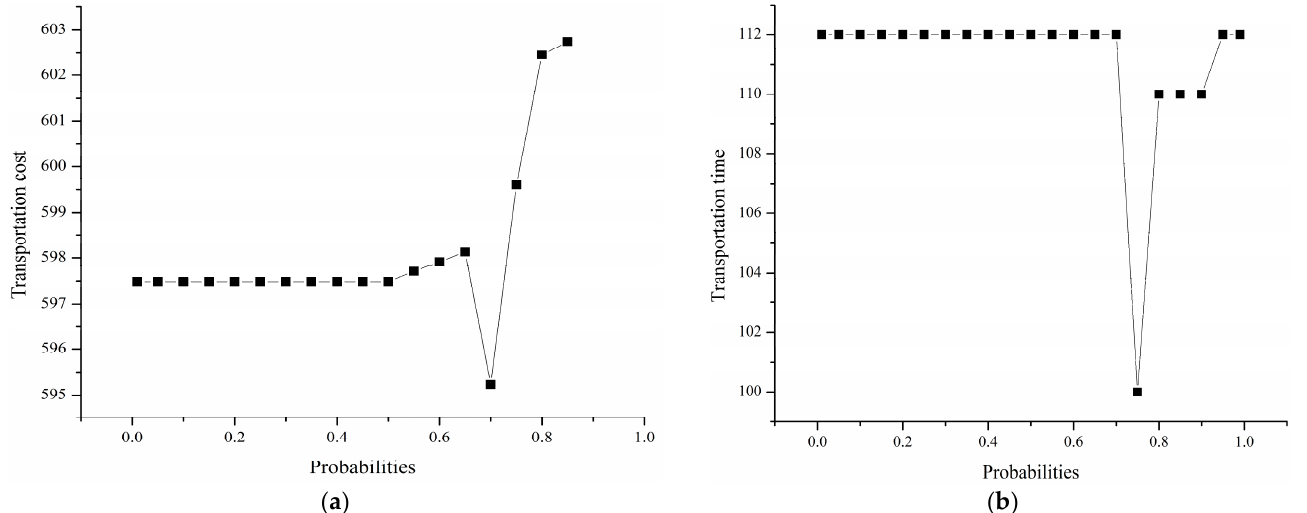
Figure 2. Sensitivity analysis of the optimal transportation cost ( a ) and time ( b ) concerning the probability of supply availability.